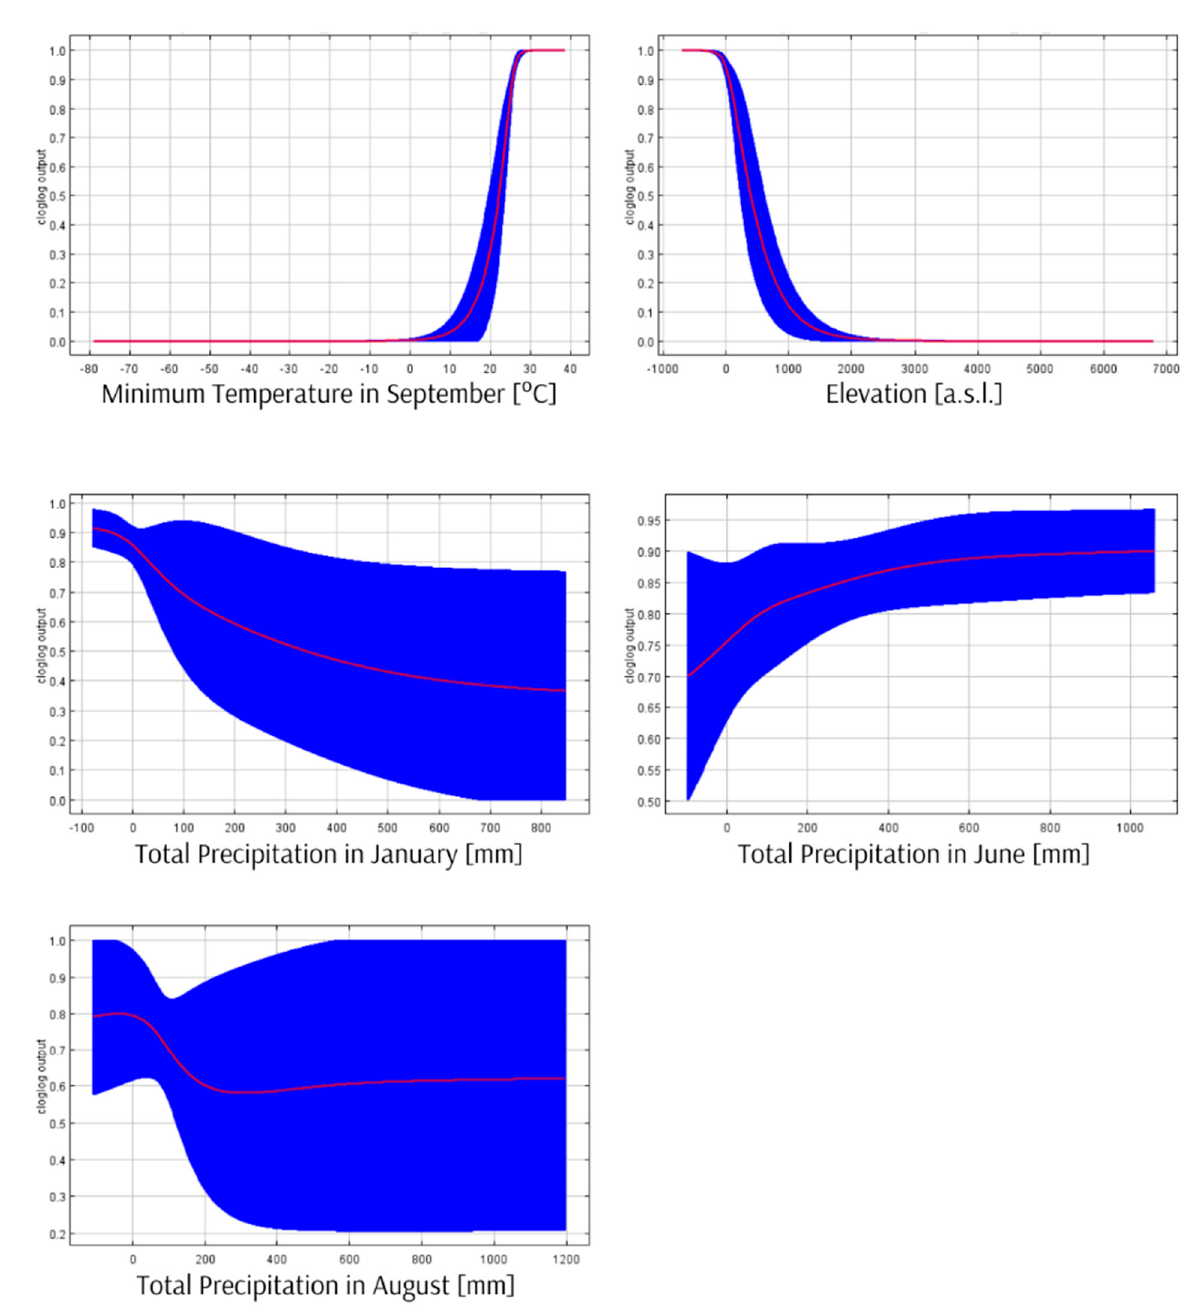
Figure 3. The environmental variables response curves. The mean response of the 10 replicate Maxent runs (red) and the mean +/ − one standard deviation (blue) show how each environmental variable affects the Maxent prediction.